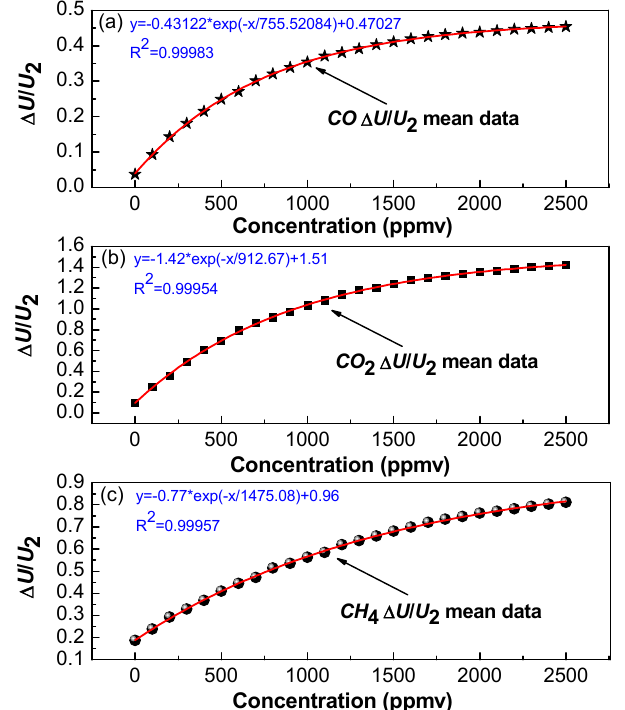
Figure 6. Experimental data dots and fitting curve of the ratio Δ U / U 2 versus ( a ) CO; ( b ) CO 2 ; ( c ) CH 4 concentration.